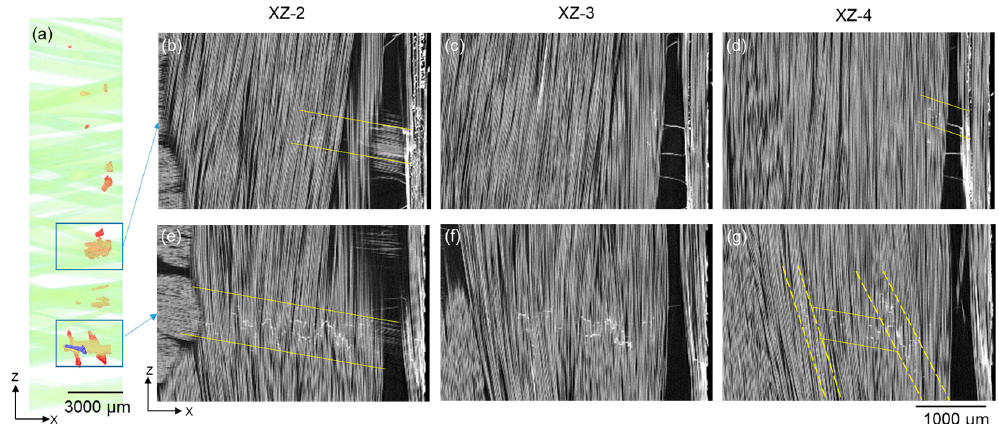
Figure 7. ( a ) XZ view of the rendered UD fibre fracture damage near the backing bundles after 500,000 cycles. ( b – g ) X-ray CT virtual XZ sections illustrating the distribution of UD fibre fractures at different positions through thickness in the specimen. The Y-positions of the XZ sections are shown in Figure 3c.